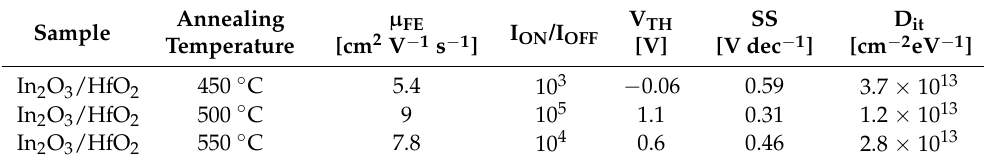
Table 1. Electrical properties of In 2 O 3 /HfO 2 at different annealing temperatures. Sample